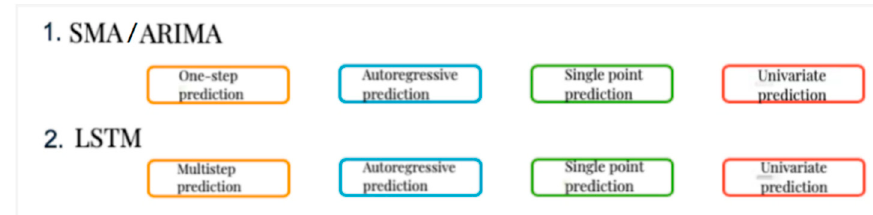
Figure 3. Time-series prediction